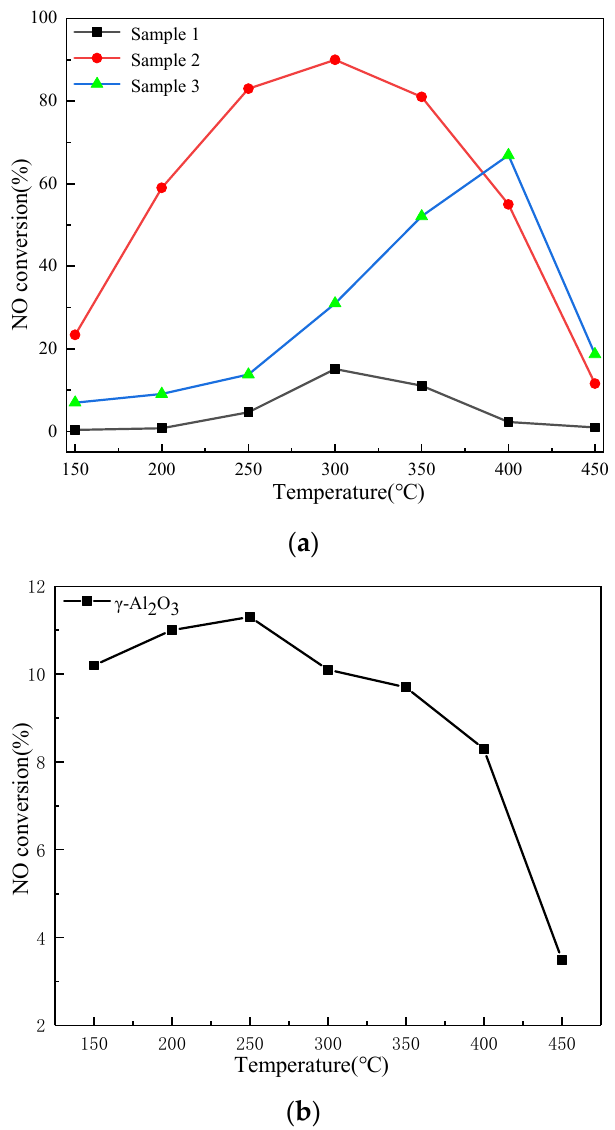
Figure 1. ( a ) The catalyst activity of different ball grinding mixing methods; ( b ) the catalyst activity of γ -Al 2 O 3